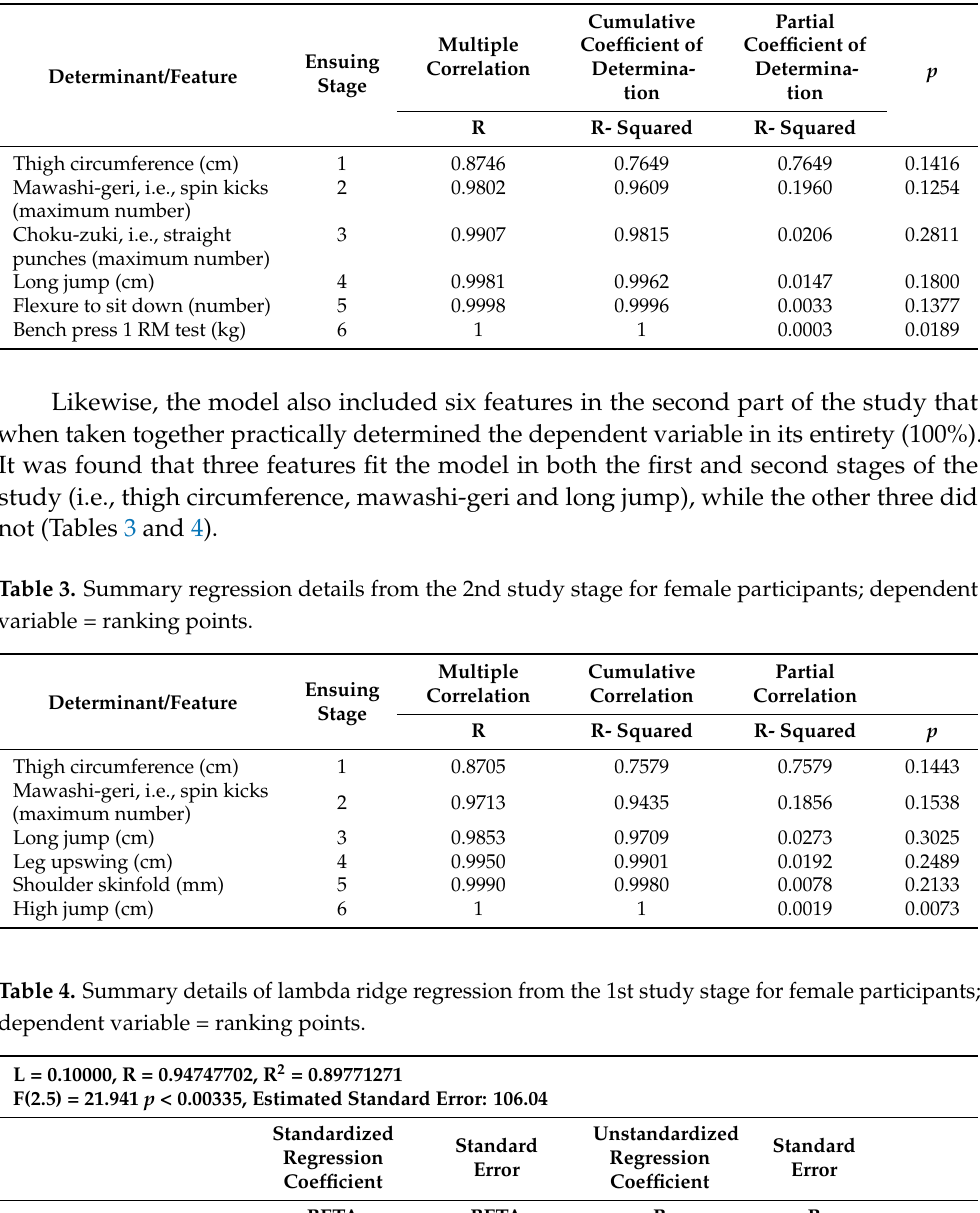
Table 2. Summary regression details from the 1st study stage for female participants; dependent variable = ranking points.